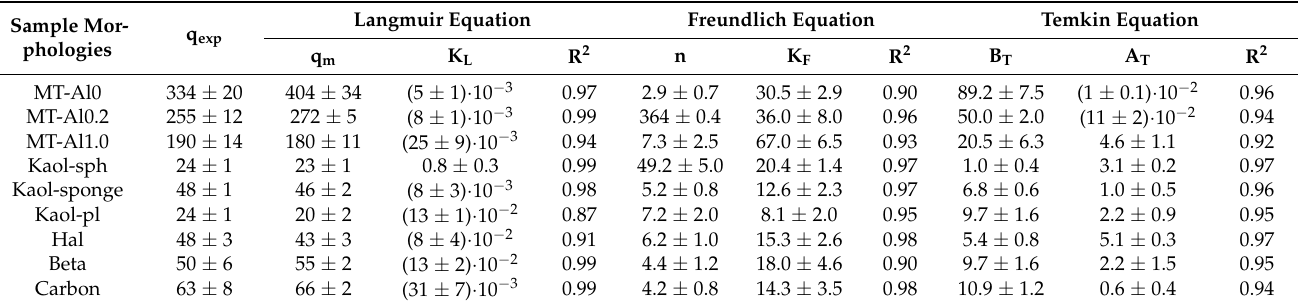
Table 4. Equation constants of albumin sorption